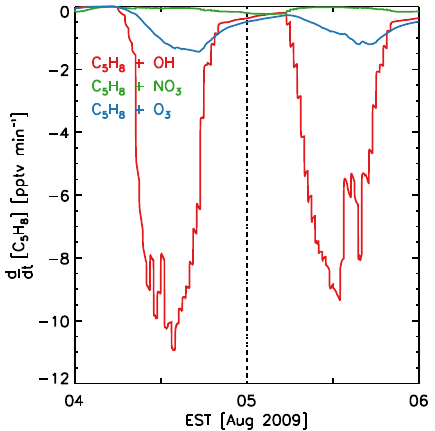
Fig. 7. Modeled isoprene loss rates with respect to reaction with OH, NO 3 , and O 3 at 34m from the MIX